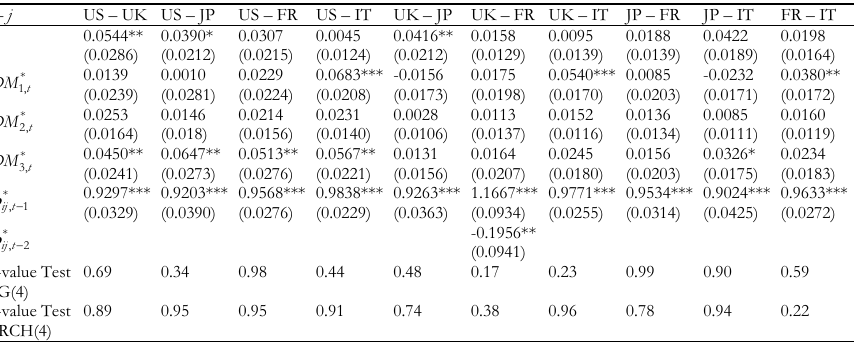
Results for the autoregressive model estimates with impulse dummy variables referred to the detected crisis